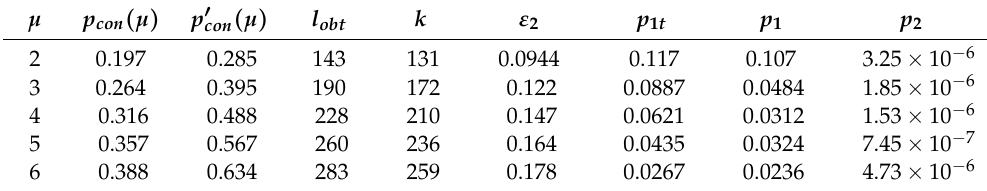
Table 1. When p = 20%, N = 800, p 2 is controlled to be a magnitude of 10 − 6 , the values of parameters with different µ